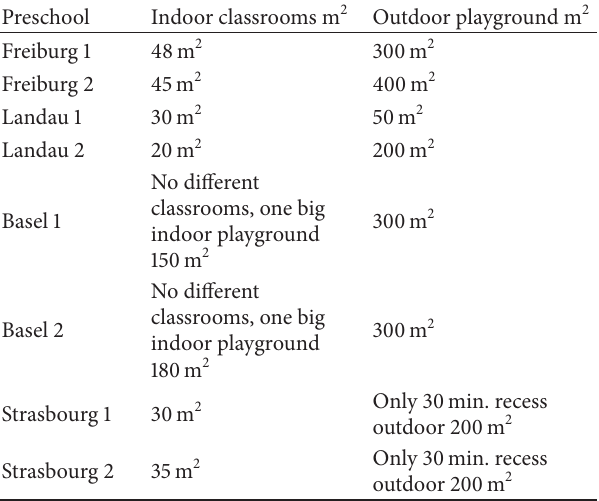
Table 2: Indoor/outdoor facilities